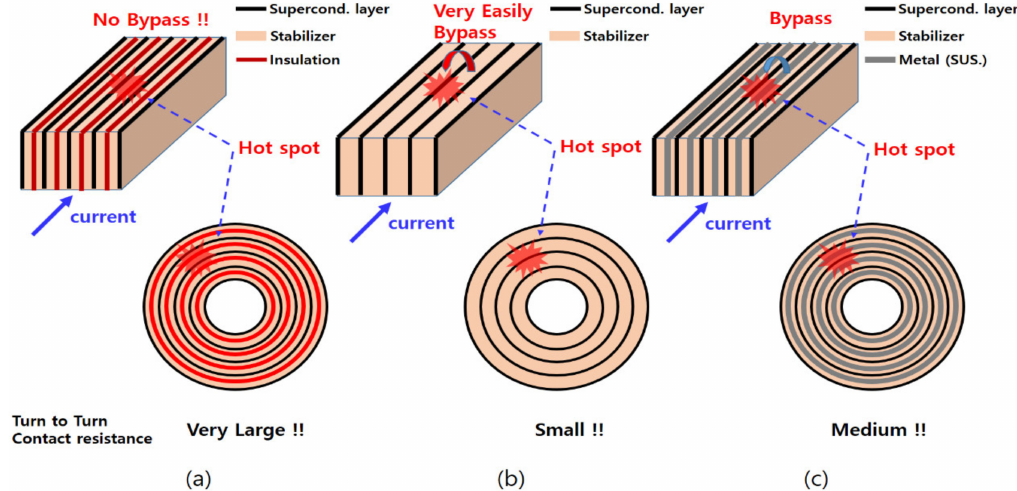
Figure 2. Quench-protection mechanism of the ( a ) insulation winding, ( b ) no-insulation winding, and ( c ) metallic- insulation